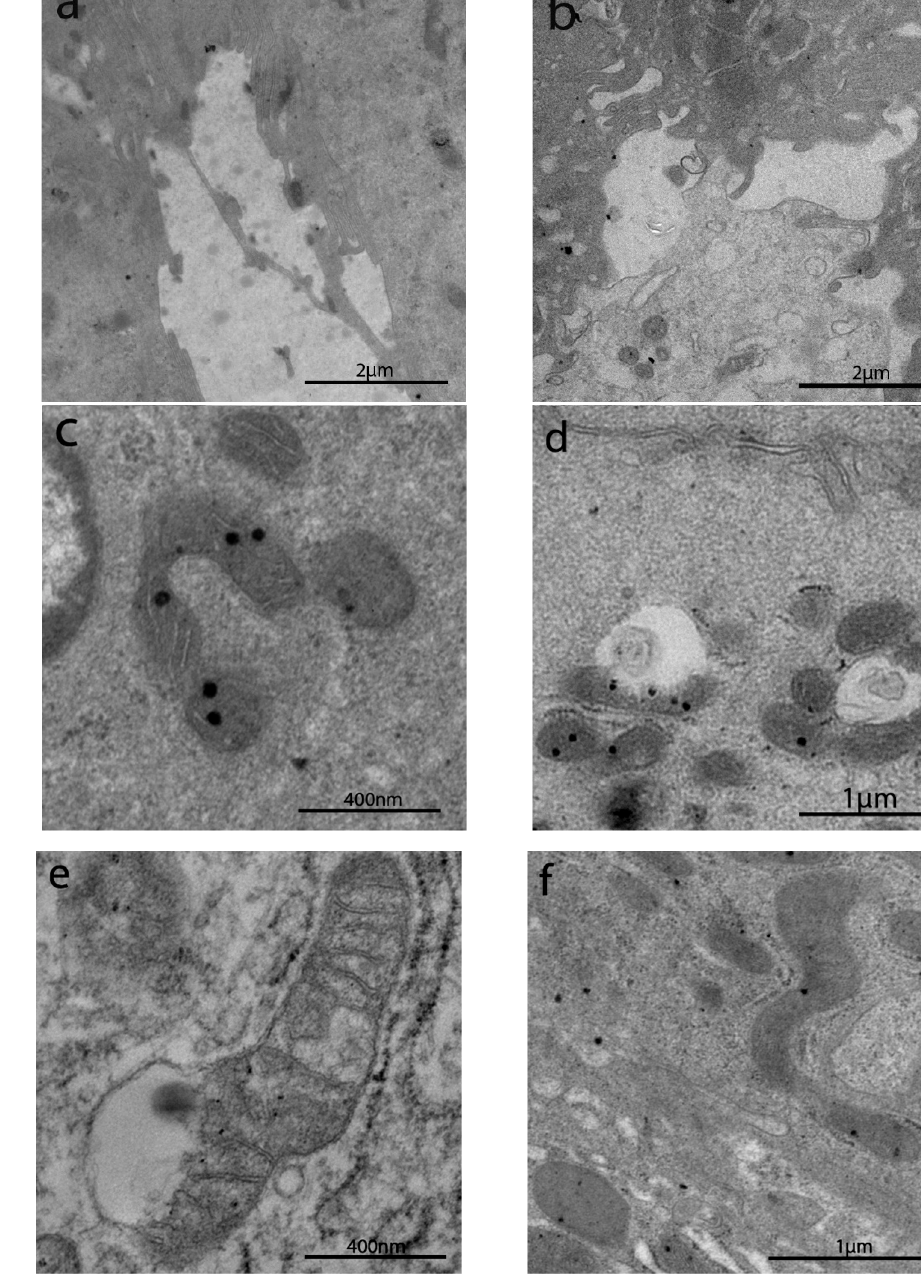
Figure 5. TEM images of apoptosis and mitochondria in IBS-like disorders. The sub-apical and lateral domain of enterocytes in NCGS ( a ) and Ni ACM ( b ) showed signs suggestive of apoptosis and reduction in cell turnover ( a , b ). Abnormal mitochondria have been observed in WA ( c ), NCGS ( d ), and Ni ACM ( e , f ); an irregular shape of these organelles was evident, with a swollen, flattened, or fissured matrix, in some cases associated with an increased rough endoplasmic reticulum (RER) ( e ).